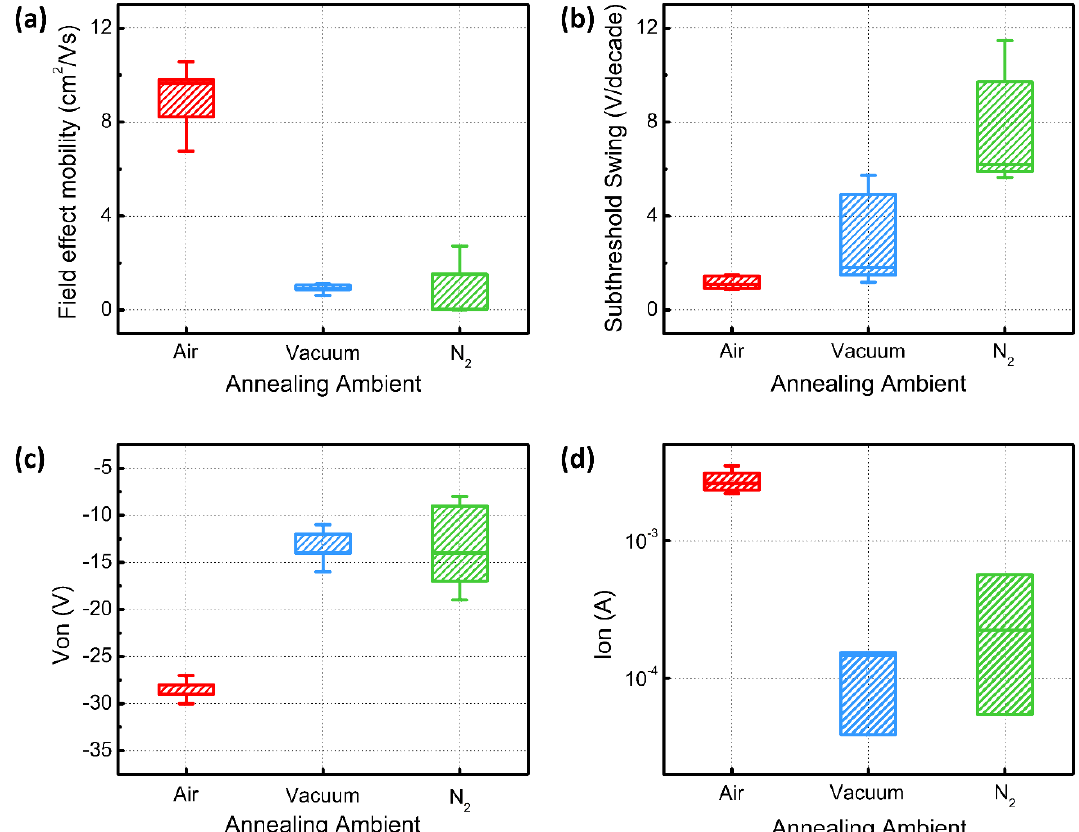
Figure 5. Extracted performance parameters of the fabricated SnO 2 thin-film transistors: ( a ) field-effect mobility in the saturation regime, ( b ) SS, ( c ) V on , and ( d ) I on .